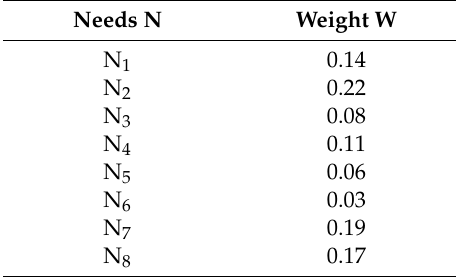
Table 5. Weight of